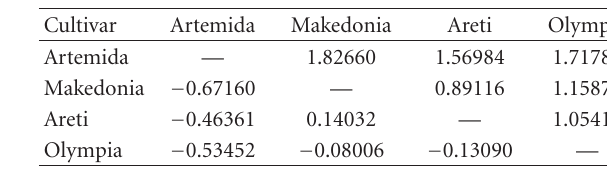
Table 2: Matrices of average taxonomic distance (above diagonal) and product moment correlation (below diagonal) for cultivars.